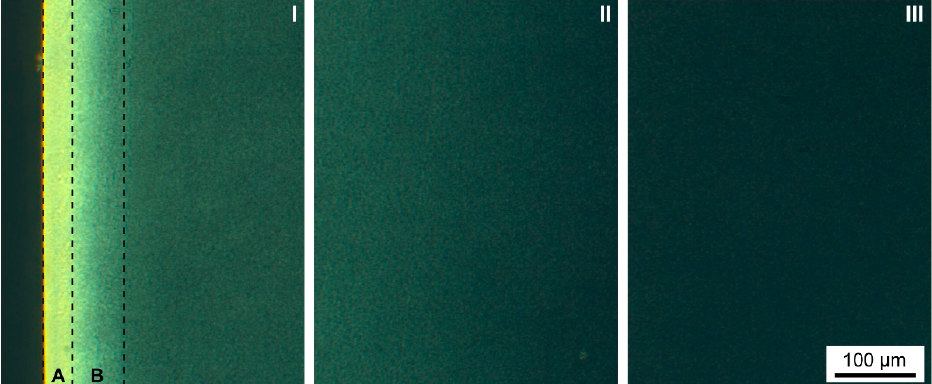
Figure 7. Optical analysis. POM micrographs on 40 µm thin sections with mold temperature M = 40 °C showing birefringence gradient existing in the different regions from the skin to the core ( I to III ). A and B represent the skin and shear-like layers, respectively.